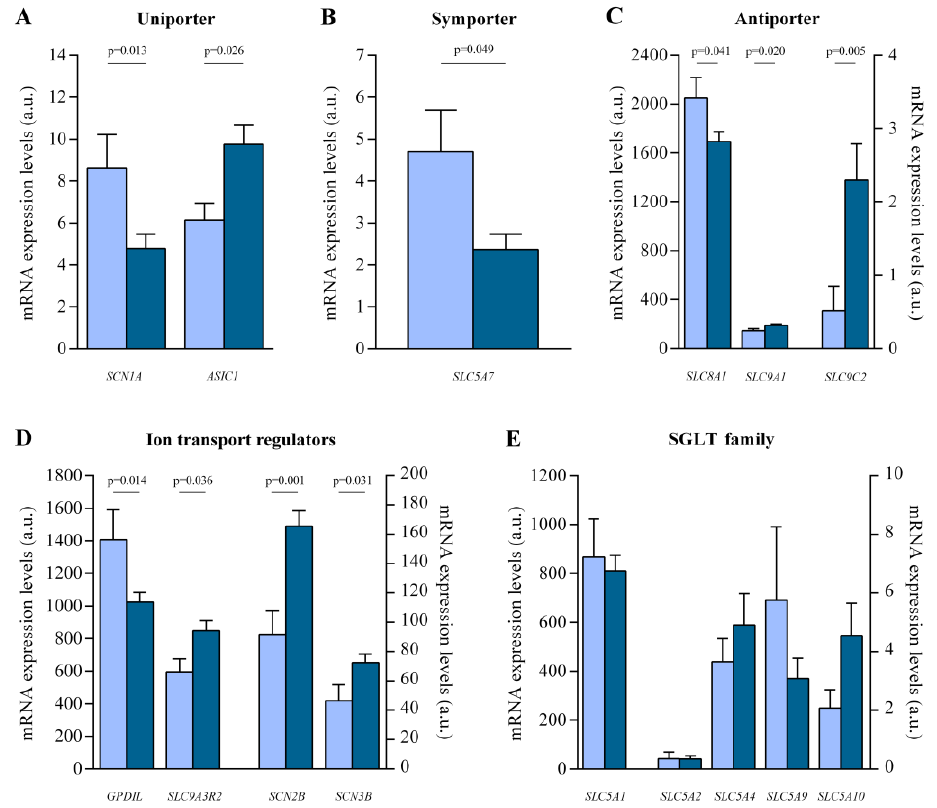
Figure 1. mRNA expression levels of altered genes involved in sodium transport in human heart failure (HF) hearts. ( A ) Uniporter ( SCN1A and ASIC1 ). ( B ) Symporter ( SLC5A7 ). ( C ) Antiporter ( SLC8A1 , SCL9A1 and SLC9C2 ). ( D ) Regulators of sodium transporters ( GPD1L , SLC9A3R2, SCN2B and SCN3B ). ( E ) Sodium/glucose cotransporter (SGLT family). Bars represent mean ± SEM values. a.u., arbitrary units. Controls subjects (n = 10; light blue) and heart failure patients (n = 26; dark blue).